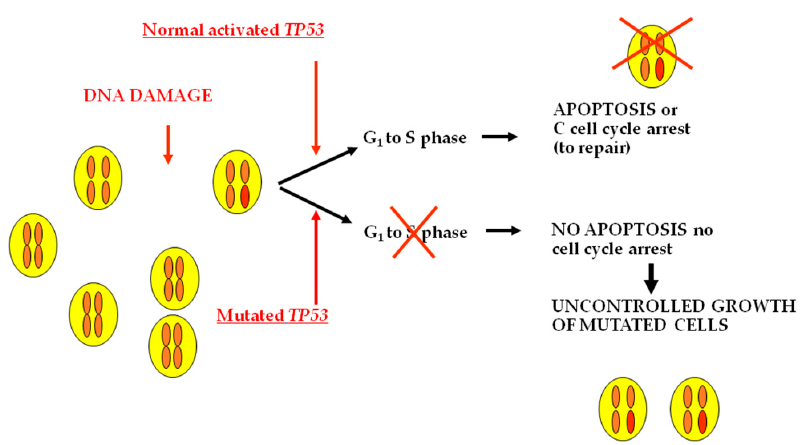
Figure 5. TP53 gene encodes for a protein involved in the control of the cell cycle. When DNA damage occurs, TP53 is able to induce the arrest of the cell cycle, and mutated cells cannot give origin to altered clones. Mutated TP53 loses the ability to stop the growth of mutated cells. Thus, tumoral clones take over.